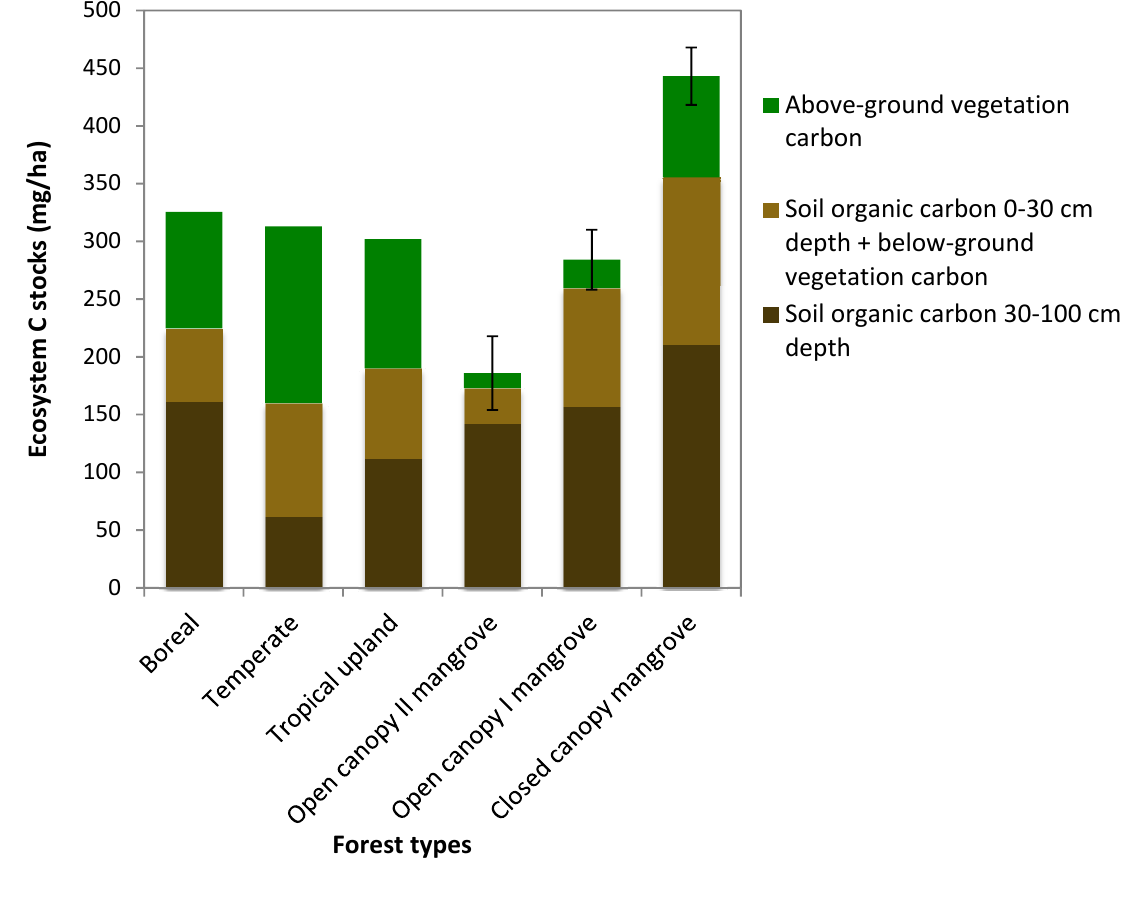
Figure 8. Estimated carbon stocks for Madagascar (±1 standard error) compared with published carbon stocks for different forest types. Carbon stocks for non-mangrove forest types are taken from [15]. Soil organic carbon comparisons are made to a depth of 1